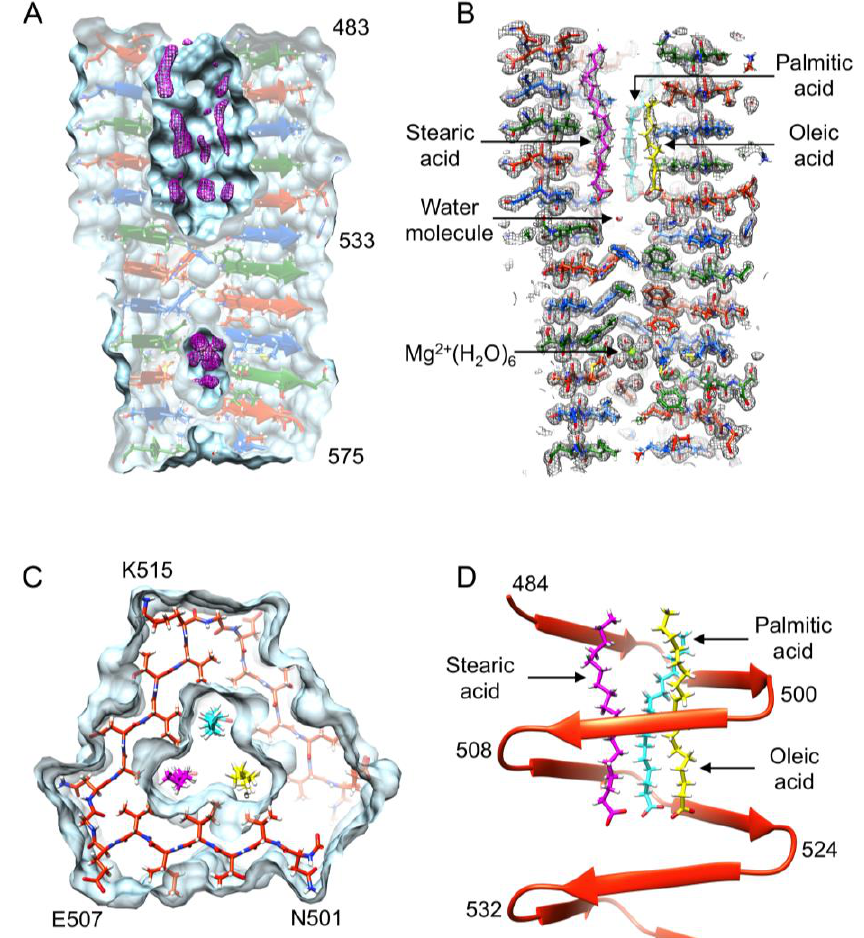
Figure 5. Features of gp5β-BC and gp5β-BC2 structures. ( A ) The Fo-Fc difference map shows that interior cavities are not empty. The difference map (purple) is contoured at 2.5 standard deviations above the mean. The molecular surface is colored aquamarine. Each chain of gp5β-BC is shown in a distinct color (firebrick red, forest green, and dodger blue); ( B ) A 6 Å-thick slice of the refined 2Fo-Fc map is shown with fitted stearic (purple), palmitic (cyan), oleic acids (yellow), and Mg 2+ (H 2 O) 6 ion. The map is contoured at 1.0 standard deviations above the mean. Carbon atoms are colored in distinct colors, but all oxygens, nitrogens and hydrogens are colored red, blue, and white, respectively; ( C ) Tight packing and interaction of fatty acids with side chains forming the interior of the cavity in gpβ-BC. The color scheme is as in panel B. One complete turn of only one polypeptide chain is shown for clarity. The molecular surface of gpβ-BC is semitransparent light blue; ( D ) Side view of the same chain as in panel (C) is shown in ribbon diagram representation.